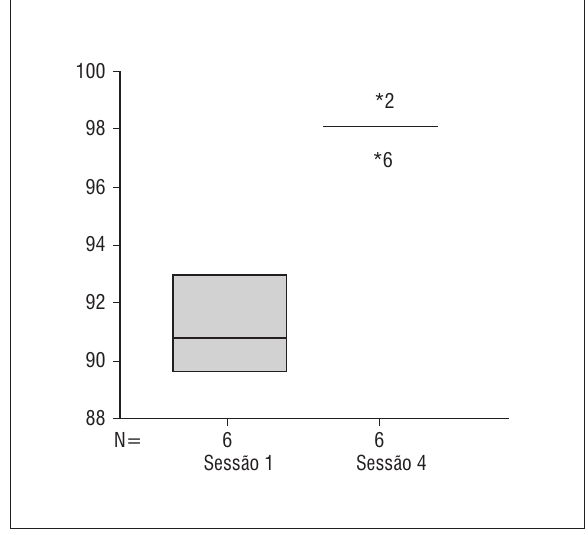
sessão 1 (inicial) 2